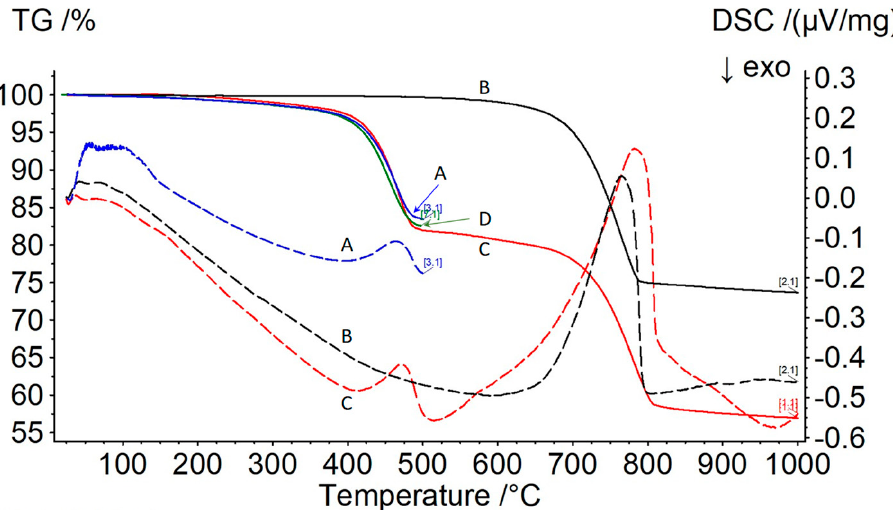
Figure 9. Thermogravimetric analysis (TGA; solid lines) and di ff erential scanning calorimetry (DSC; dashed lines) of Piceance Basin oil shale pyrolyzed under humid carbon dioxide to 500 °C (A), subsequently decomposed under dry argon by heating to 1000 °C (B; same specimen as (A)), a new specimen decomposed under dry argon by heating to 1000 °C without pre-treatment (C), and a new specimen decomposed under dry helium by heating to 500 °C without pre-treatment (D).